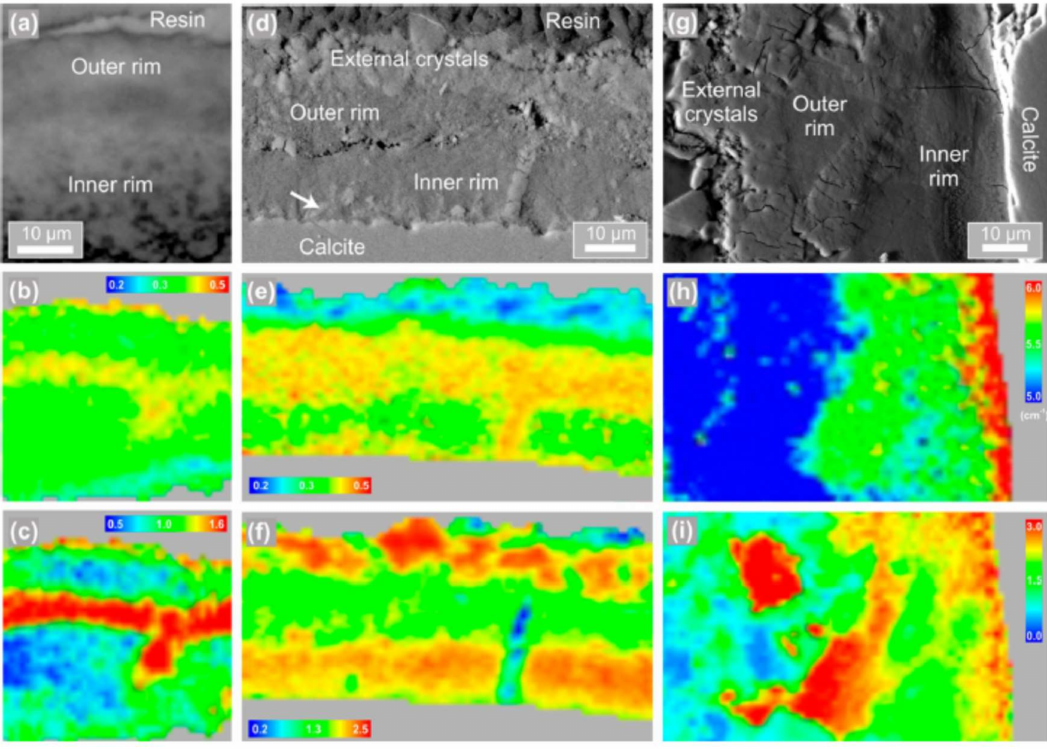
Figure 5. Reaction rims produced on marble cubes reacted with 0.1 M oxalic acid at 60 ◦ C for 7 days. ( a ) shows a reflected light microscope image of a reaction rim generated in a 50 at.% 18 O-enriched solution. ( b , c ) show the 18 O fraction in the solid and the relative crystal orientation, respectively. ( d ) is an electron backscattered image of another section of the reaction rim, where ( e ) is a map of the 18 O fraction, and ( f ) is a map of the relative crystal orientation in the area in ( d ). ( g ) displays an equivalent area of the rim generated in an experiment with natural abundance water ( 16 O-rich). ( h ) shows the difference in crystallinity of the reaction rim area shown in ( g ), reflected by the half width of the most intense oxalate band, whereas ( i ) shows the relative crystal orientation for the same area. Reprinted with permission from Crystal Growth and Design, vol. 14, “Forming cohesive